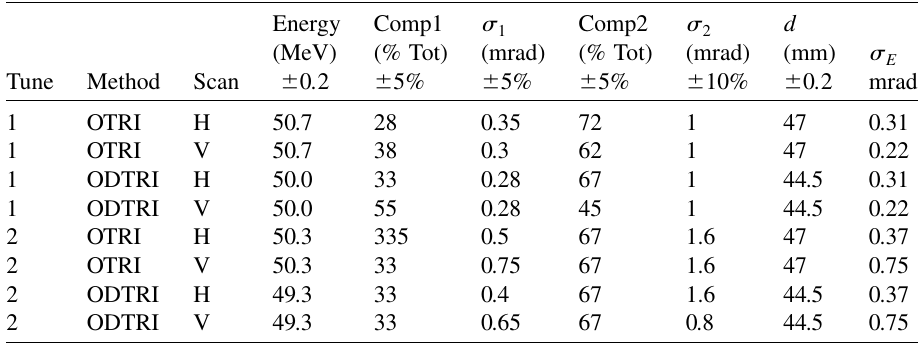
TABLE II. Fitted beam parameters for ATF beam tunes 1 and